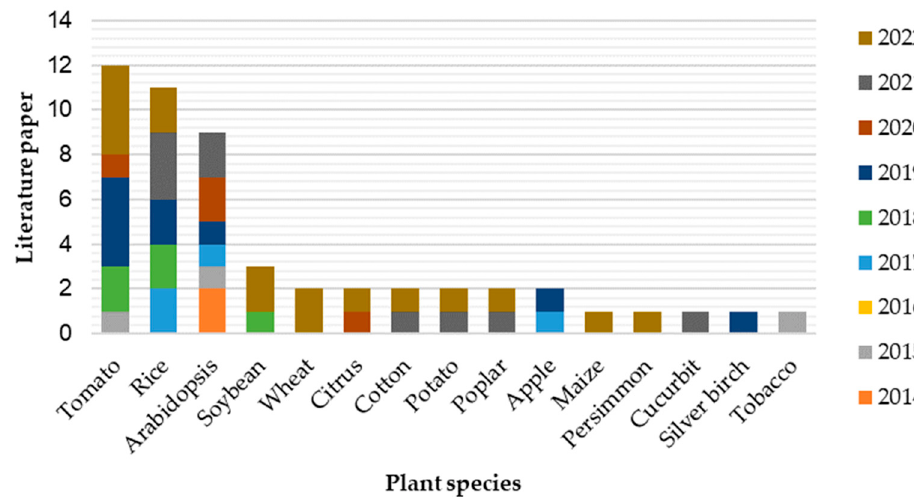
Table 2. Diverse plant species and STTM targets for miRNA functional discovery.